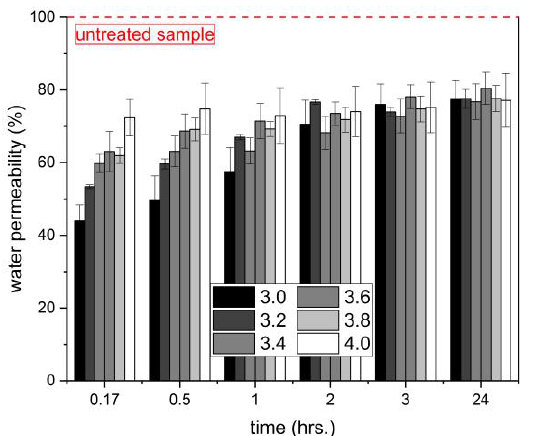
Figure 5. Water absorption of treated samples after applying the lithium silicate